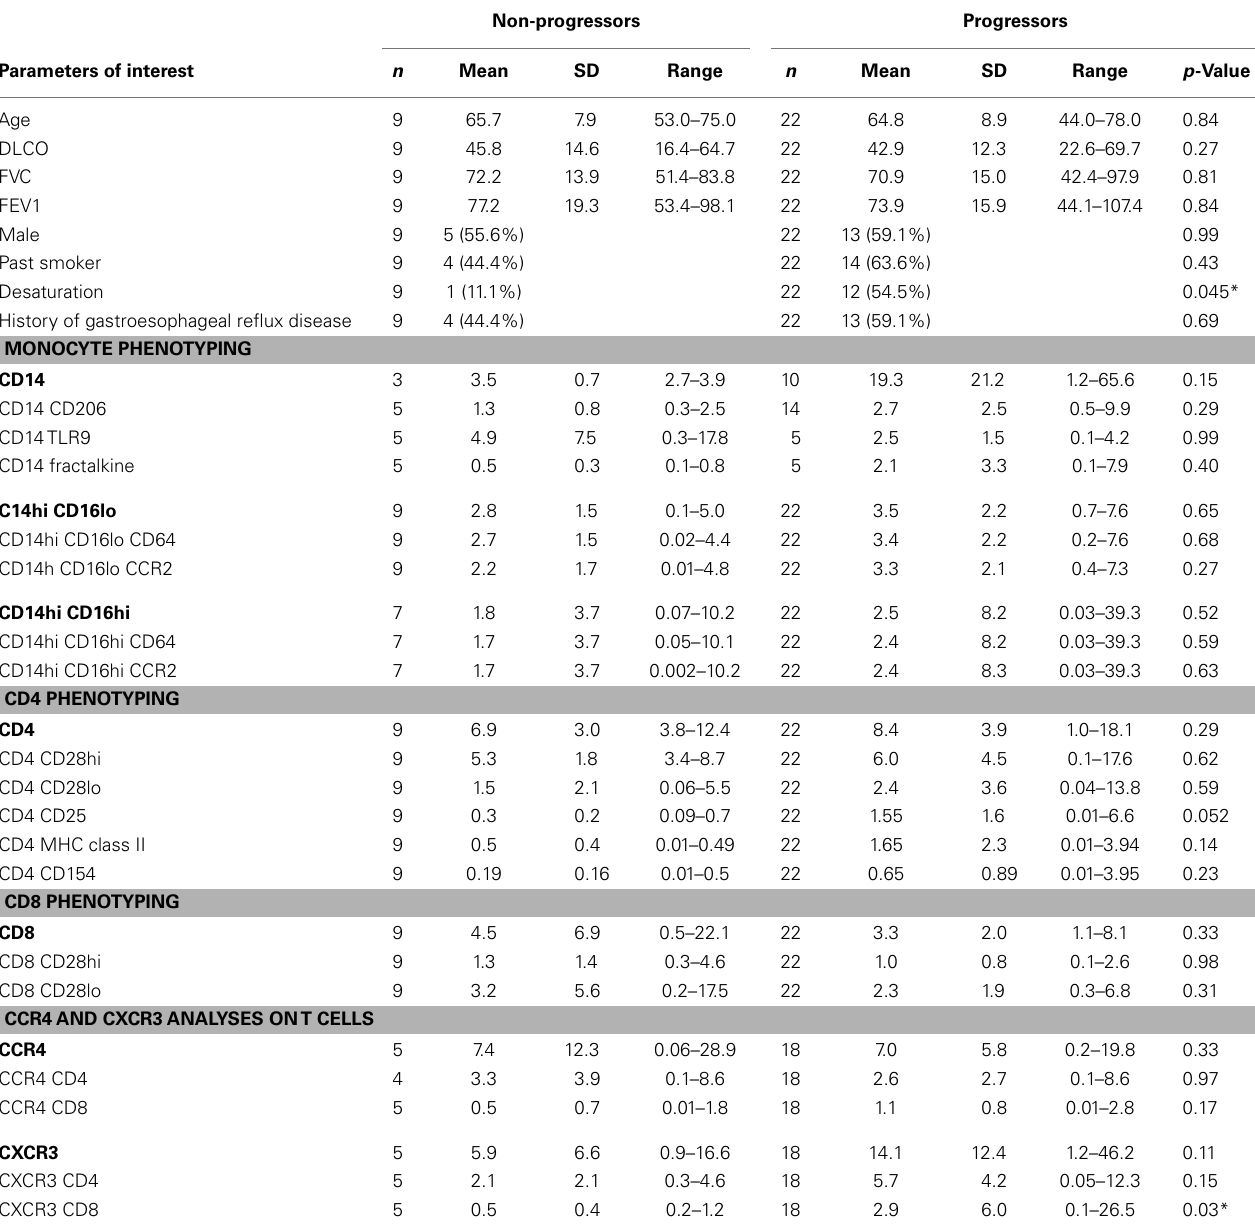
Table 1 | Demographics, pulmonary function, and biomarker levels for patients stratified on the basis of disease progression .